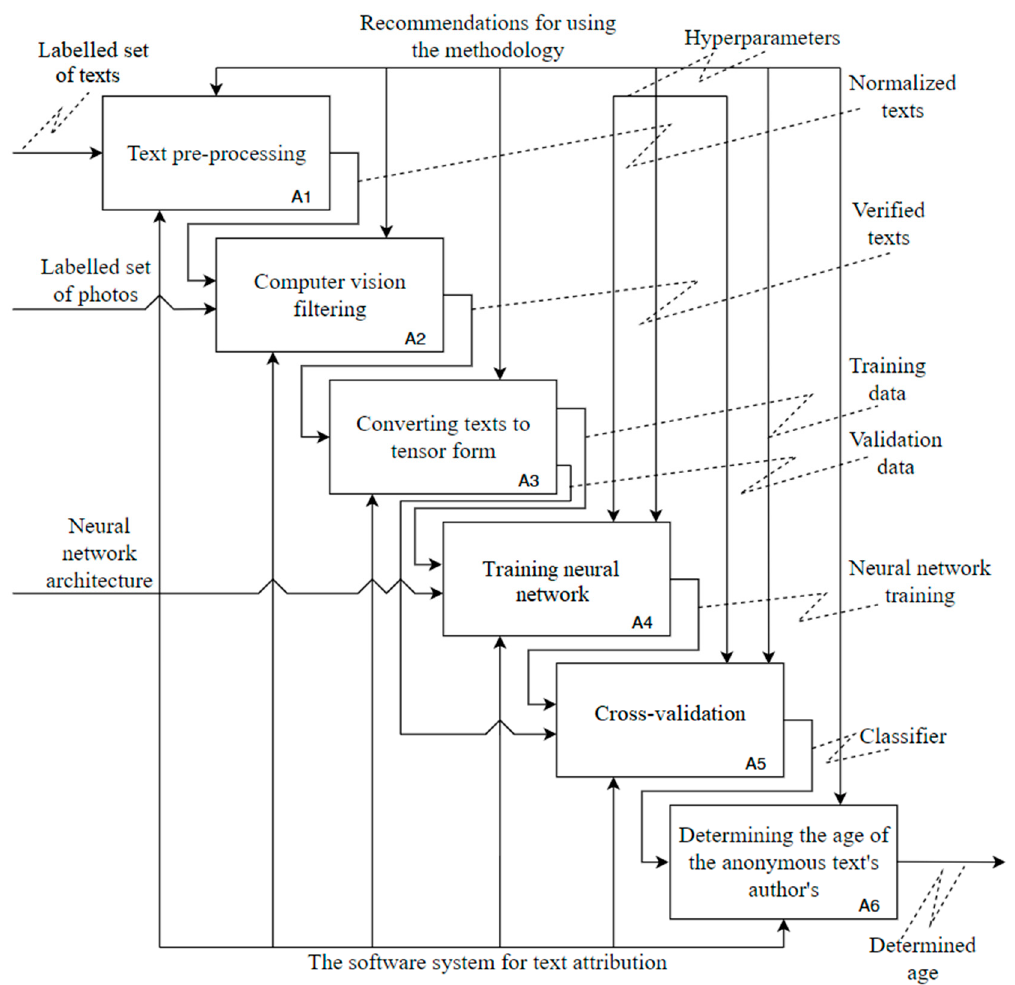
Figure 1. The method for determining the age of the author of the text.